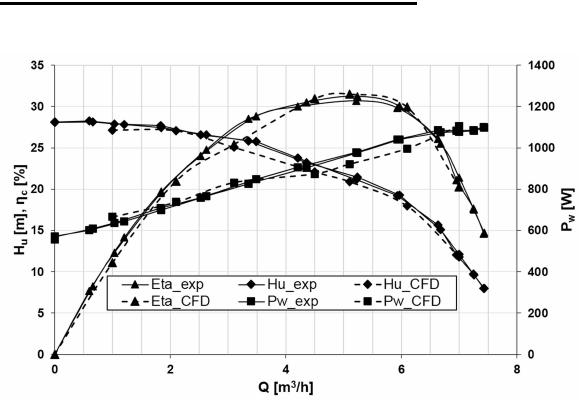
Figure 8: Comparison of characteristics determined numerically and